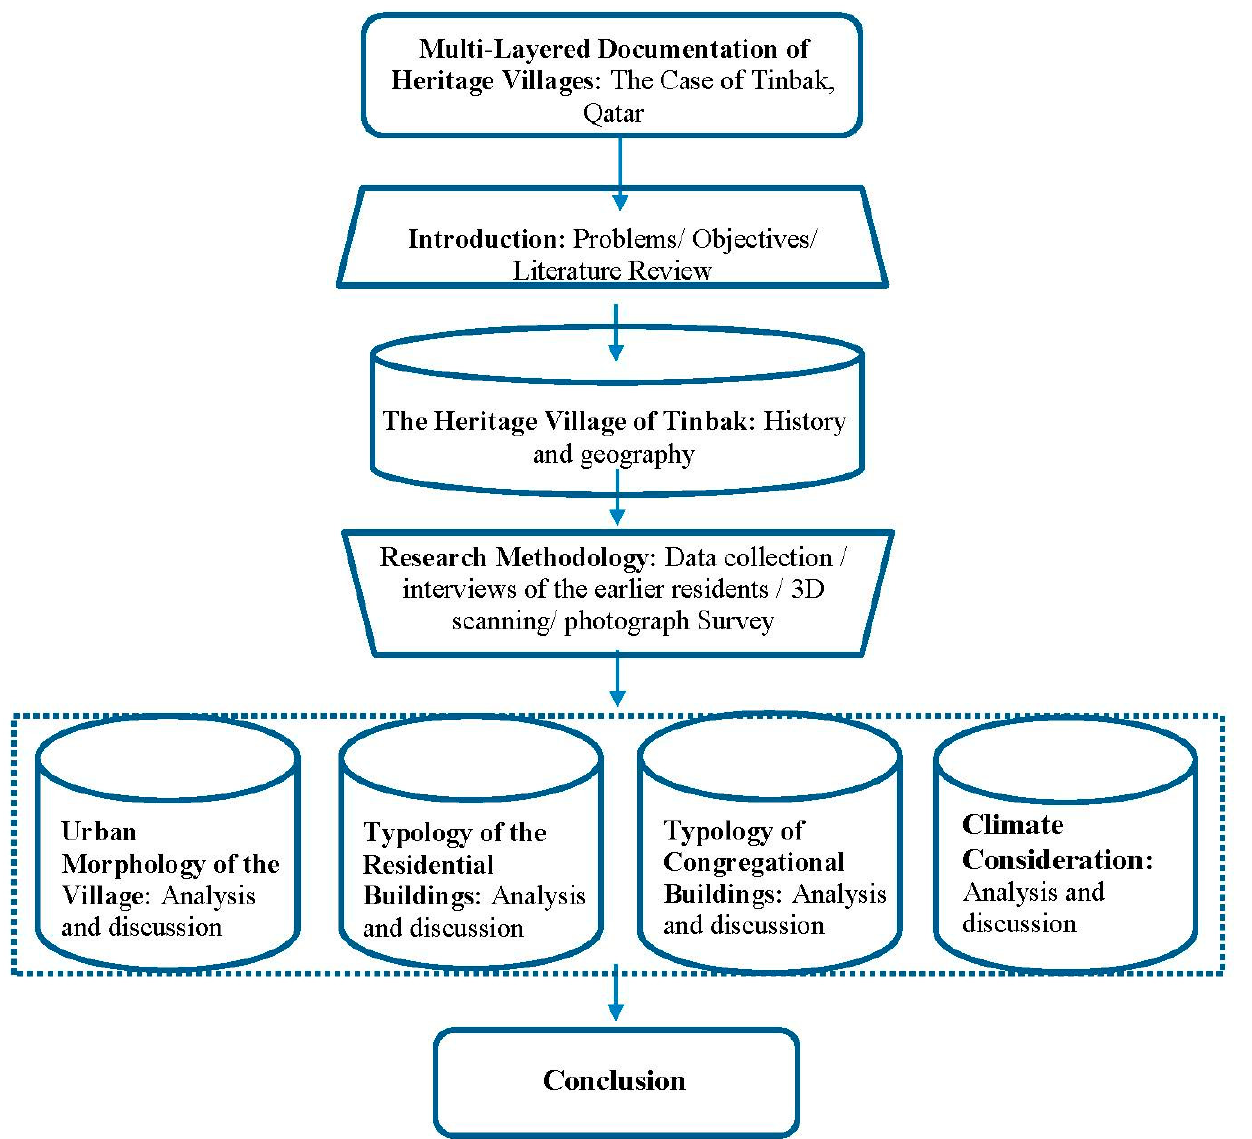
Figure 3. shows the research flowchart. Figure 3. The research